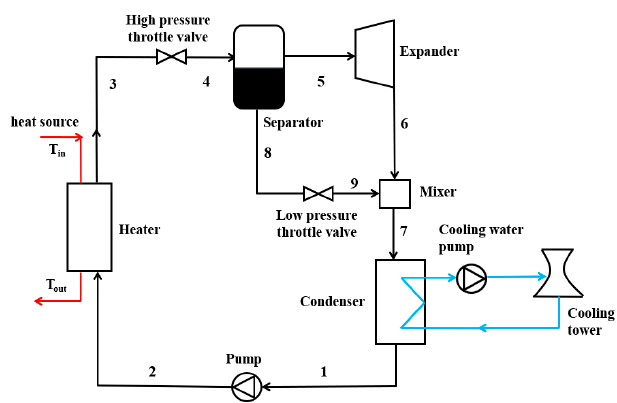
Figure 1. The OFC system diagram.